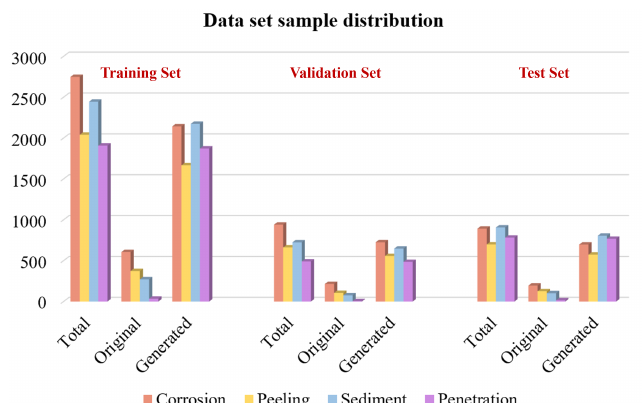
Figure 14. Proportion of sample distribution in the training set, validation set, and test